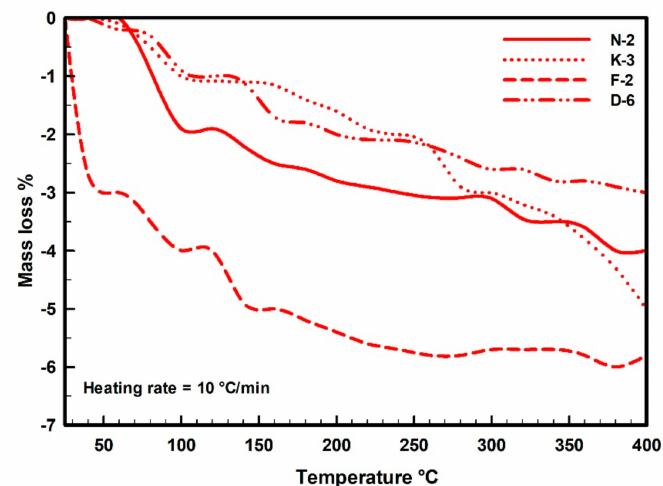
Figure 8. Dehydration thermal mass balance curves indicating moisture contents and mass loss rates (TG%) of the measured kaolin powder samples (25–400 ◦